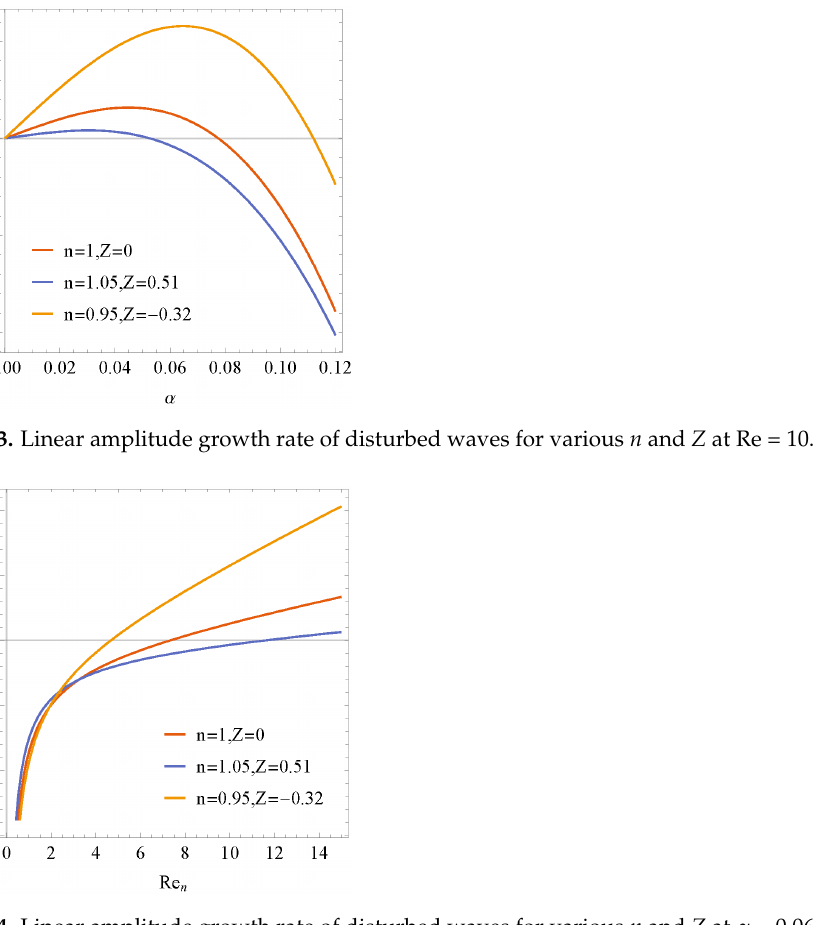
Figure 4. Linear amplitude growth rate of disturbed waves for various n and Z at α = 0.06.